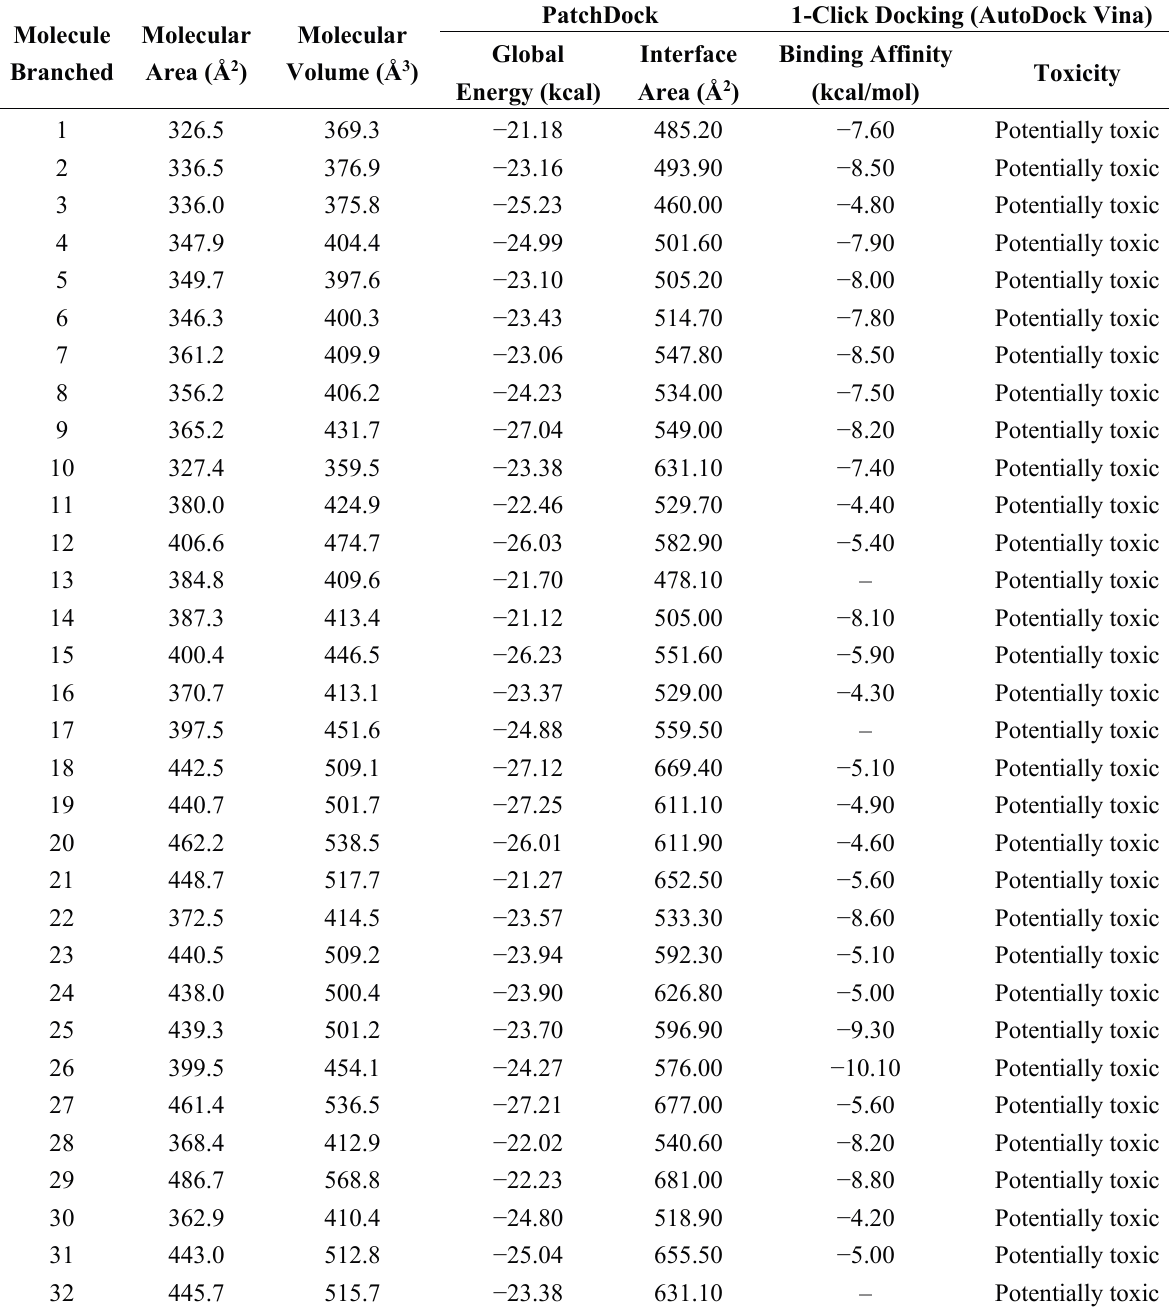
Table 4. The same type of results as in Tables 2 and 3, yet here for the BraS configuration of molecules of Table